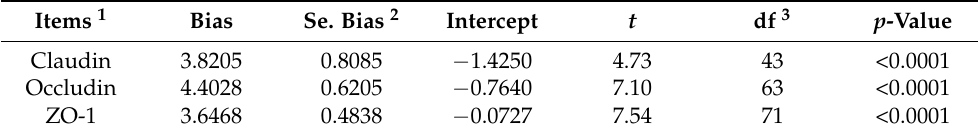
Figure 4. Funnel plot to evaluate publication bias. ( A ) claudin, ( B ) occludin, ( C ) ZO ‐ 1.